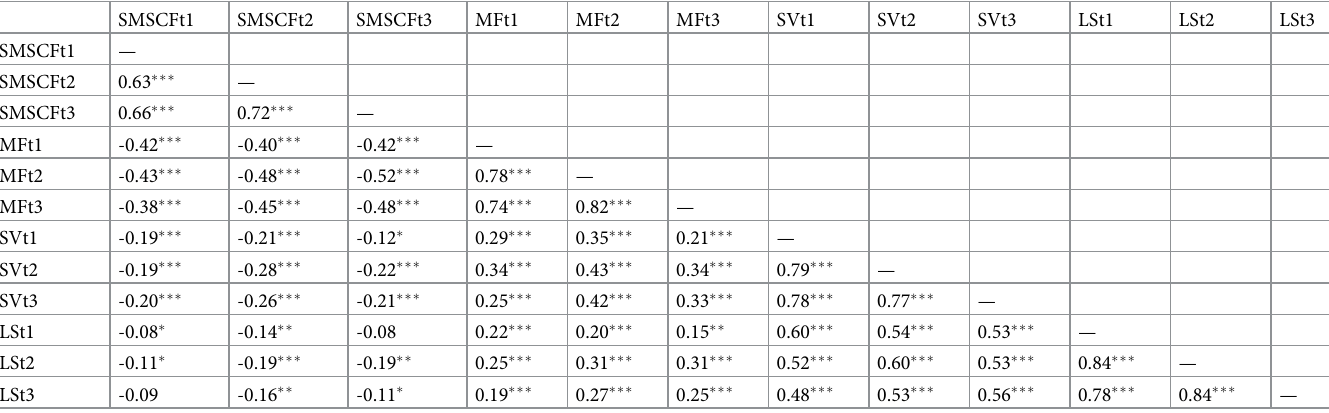
Table 4. Correlation matrix of the variables in the model across three